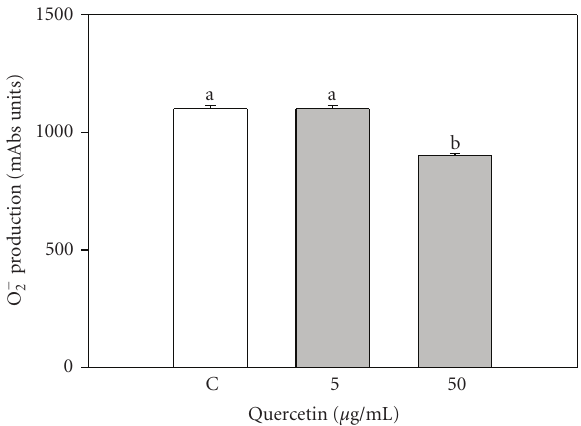
Figure 6: E ff ect of the 48-hour treatment with quercetin (5 and 50 μ g/ml) on Vascular Endothelial Growth Factor (VEGF) production by swine granulosa cell cultured in vitro. Data represent the mean ± SEM of six replicates/treatment repeated in four dif- ferent experiments. Di ff erent letters indicate significant di ff erences ( P < . 001) calculated by ANOVA and Sche ff `e’s F-test (Statgraphics package, STSC Inc., Rockville, Md,